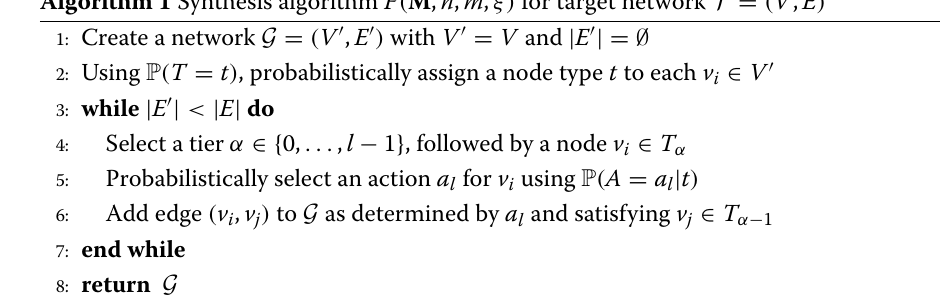
Algorithm 1 Synthesis algorithm F ( M , n , m , ξ) for target network T = ( V , E